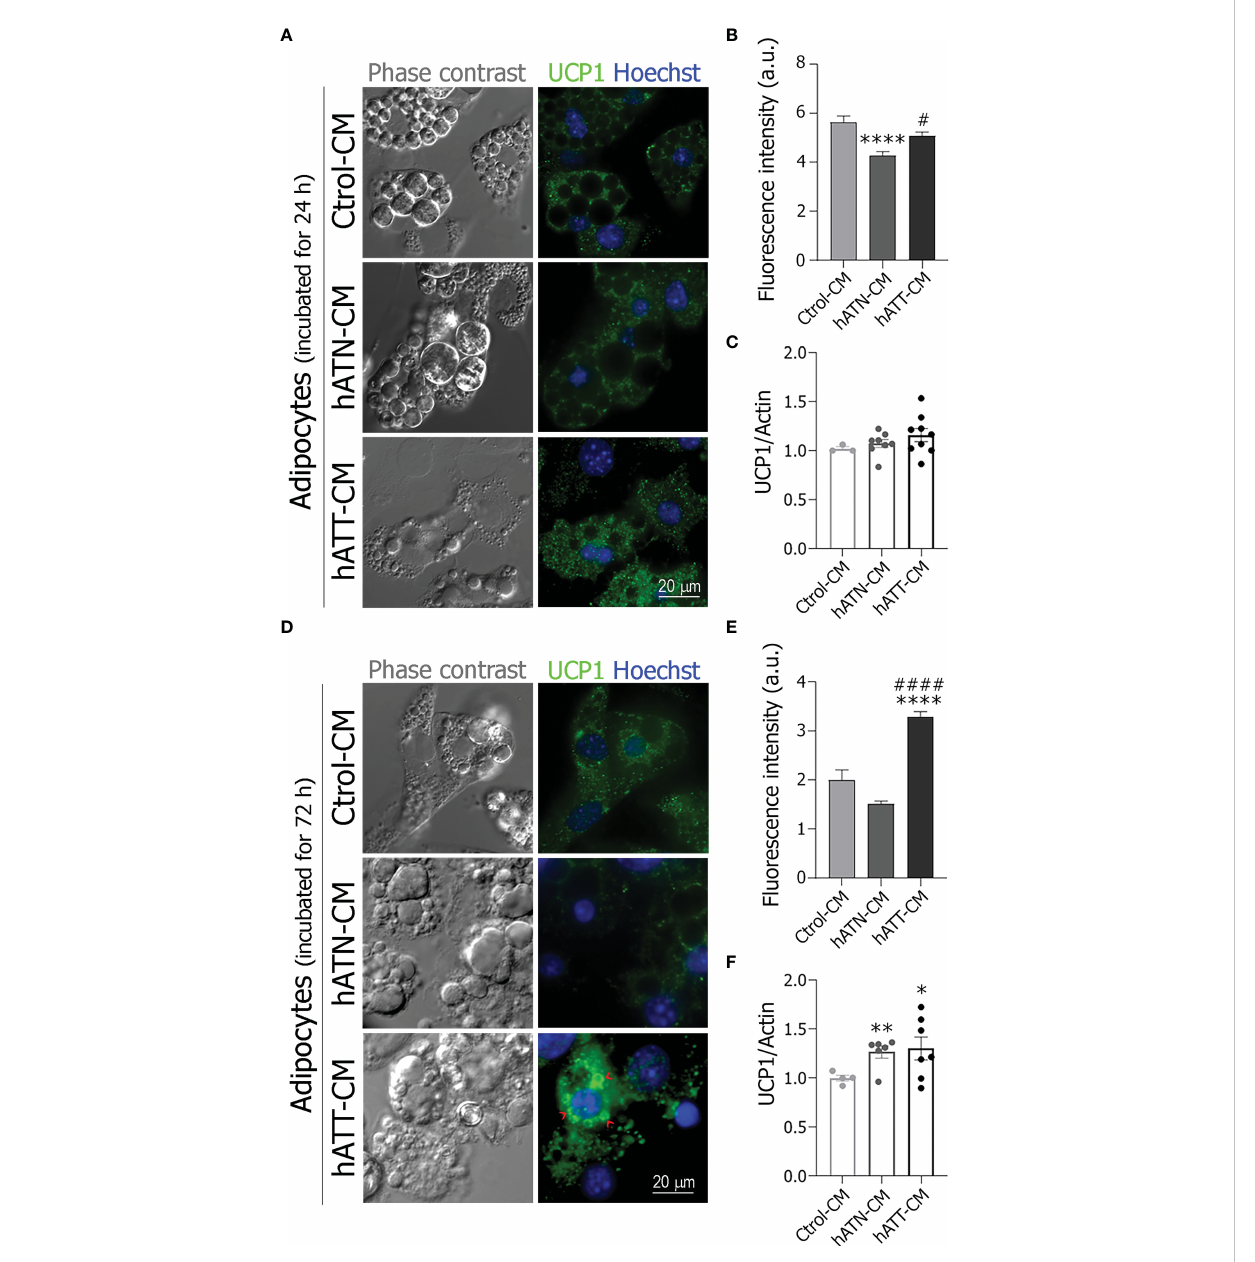
FIGURE 5 Effect of hATN- and hATT-CM on the subcellular localization and the protein expression of UCP1. 3T3-L1 adipocytes were incubated with hATN-, hATT- or Ctrol-CM for 24 (A) and 72 h (D) , and subjected to IIF with the indicated antibodies. The images were analyzed by confocal microscopy (magni fi cation x600; see Materials and methods section for further details). Red arrow heads show examples of micro-LDs. Fluorescence intensity was measured from 43 adipocytes incubated with the different CM for 24 or 72 h ( B, E , respectively). (n = 3 experiments in duplicate). Tukey ’ s multiple comparison test was performed. 3T3-L1 adipocytes were incubated with hATN-, hATT- or Ctrol-CM for 24 and 72 h, then lysed and the expression of UCP1 was measured by WB ( C, F , respectively). Actin was used as a loading control. Images were analyzed by densitometry. (n = 3-4 experiments in duplicate). Student ’ s t-test with Welch ’ s correction was performed; *P<0.05, **P<0.01 and ****P<0.0001 adipocytes incubated with hATT-CM or hATN-CM vs. Ctrol-CM; #P<0.05 and ####P<0.0001 adipocytes incubated with hATT-CM vs. hATN-CM. a.u., arbitrary units; Ctrol- CM, control conditioned media; hATN-CM, conditioned media from human normal breast adipose tissue explants; hATT-CM, conditioned media from human breast cancer adipose tissue explants; UCP1, Uncoupling protein